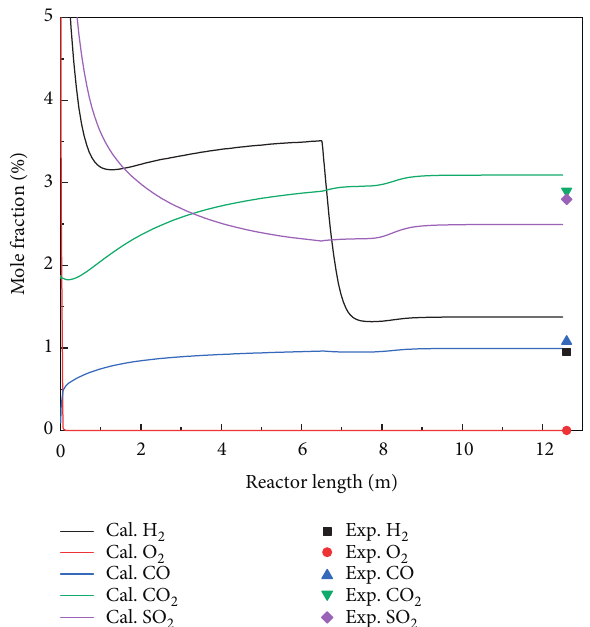
Figure 6: Gas-phase species composition along with the TR and WHB of industrial data and the calculation result (magnified).